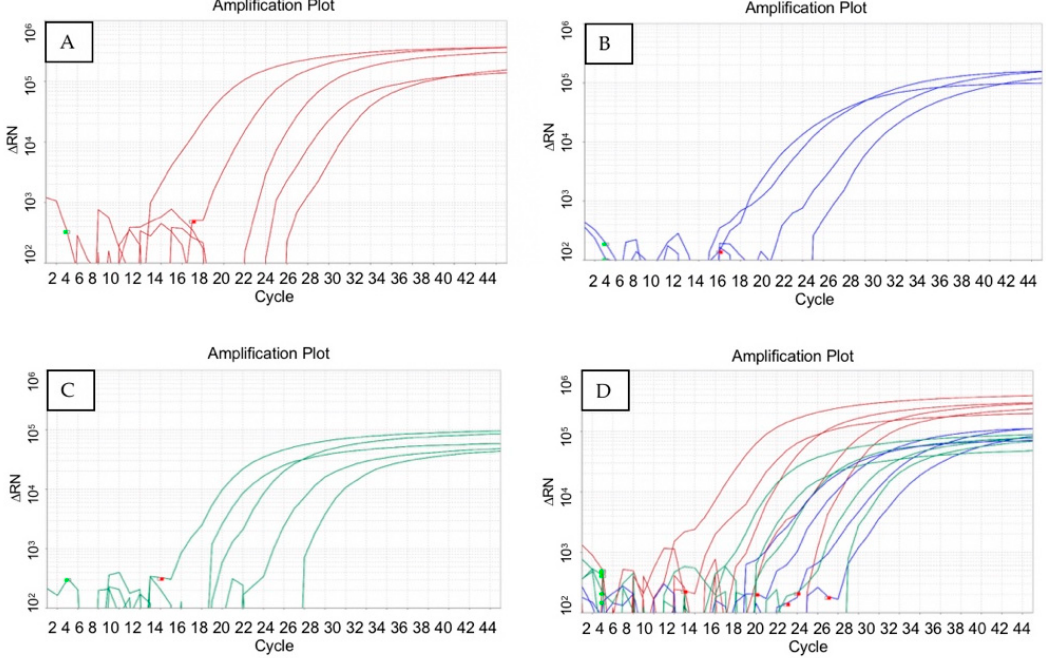
Figure 4. Real-time multiplex PCR. Ampli fi cation curves of serial dilutions from 10 6 to 10 2 PFU/mL of vRsoP-WF2, vRsoP- WM2, and vRsoP-WR2 phages (( A )—red), ampli fi cation curves of serial dilutions from 10 6 to 10 3 CFU/mL of Ralstonia solanacearum (( B )—blue), ampli fi cation curves of serial dilutions from 10 6 to 10 3 CFU/mL of vRsoP-WR2 phage (( C )— green), and ampli fi cation curves of serial dilutions from 10 6 to 10 2 CFU/mL of vRsoP-WF2, vRsoP-WM2, and vRsoP-WR2